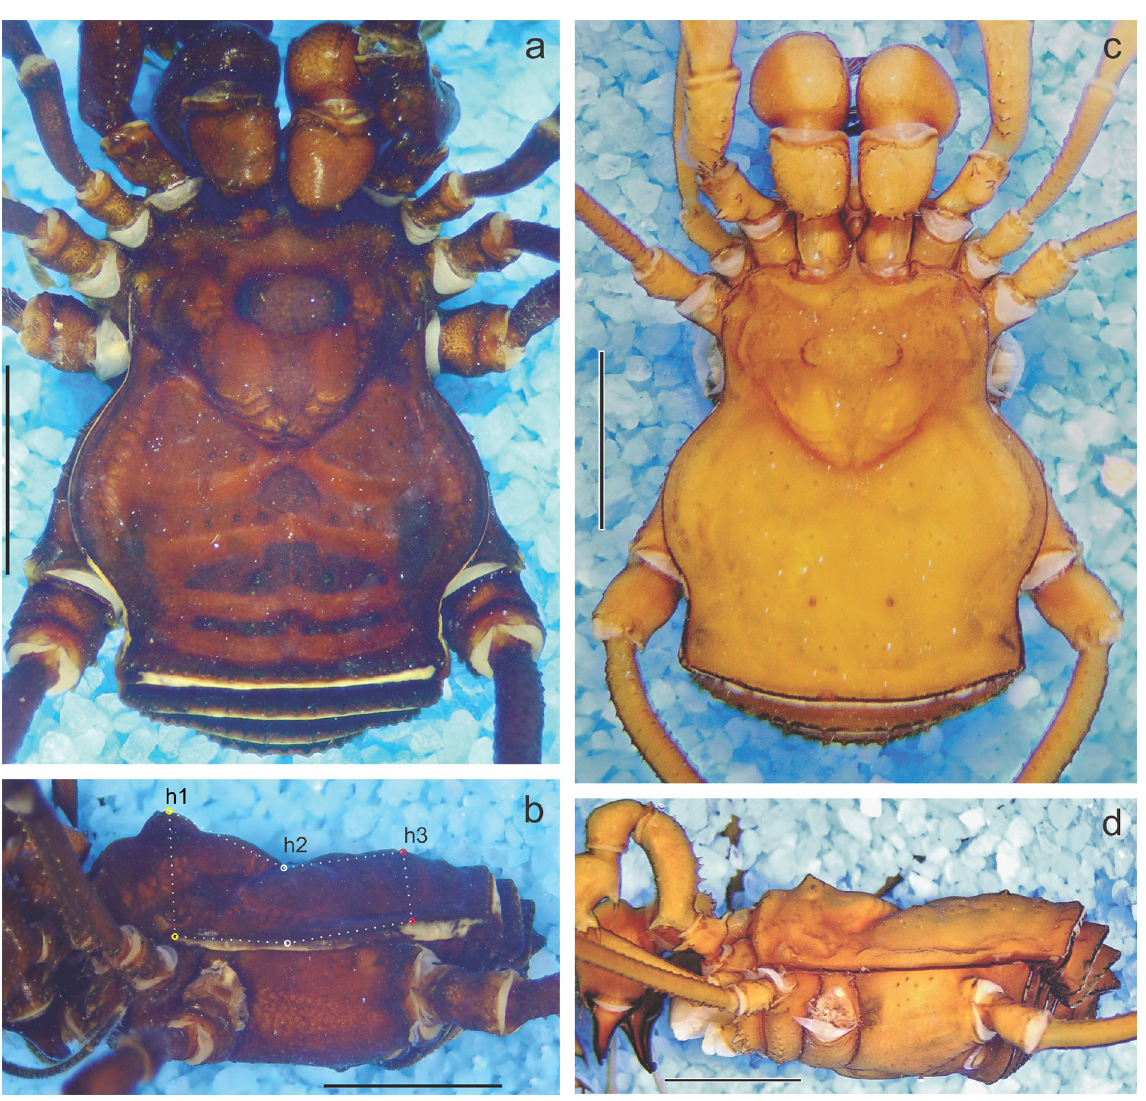
Fig. 1. Phalangodus anacosmetus Gervais, 1842 , ♂ (ICN-AO-1000). a . Habitus, dorsal view. b . Habitus, lateral view, ♀ (CAS 0019). c . Habitus, dorsal view. d . Habitus, lateral view. Scale bars = 5 mm. Abbreviations: see Material and